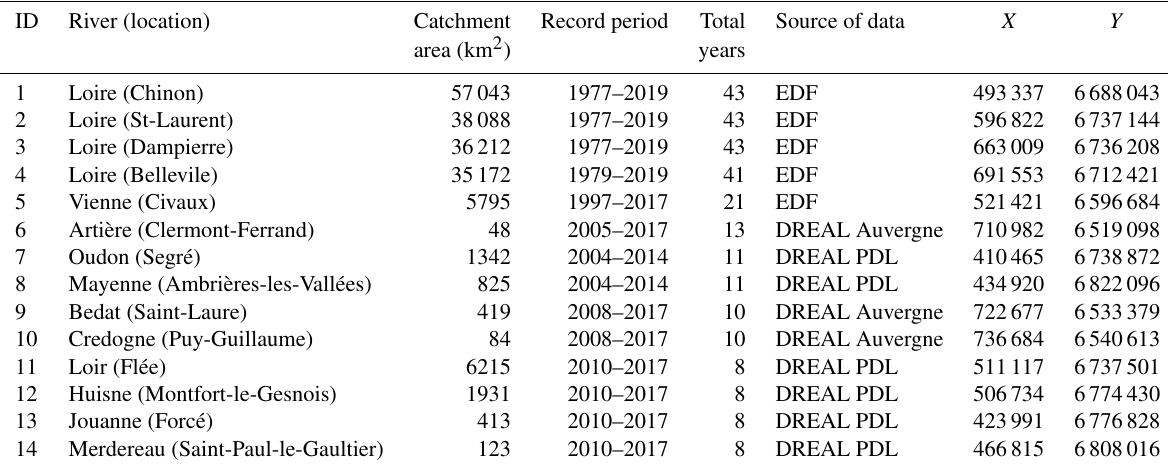
Table 1. Characteristics of the 14 long-term T w stations. See Fig. S4 for the evolution of observed annual T w at these stations. The IDs of stations correspond to the numbers (in red) shown in Fig. 1, middle. The coordinate system is Lambert